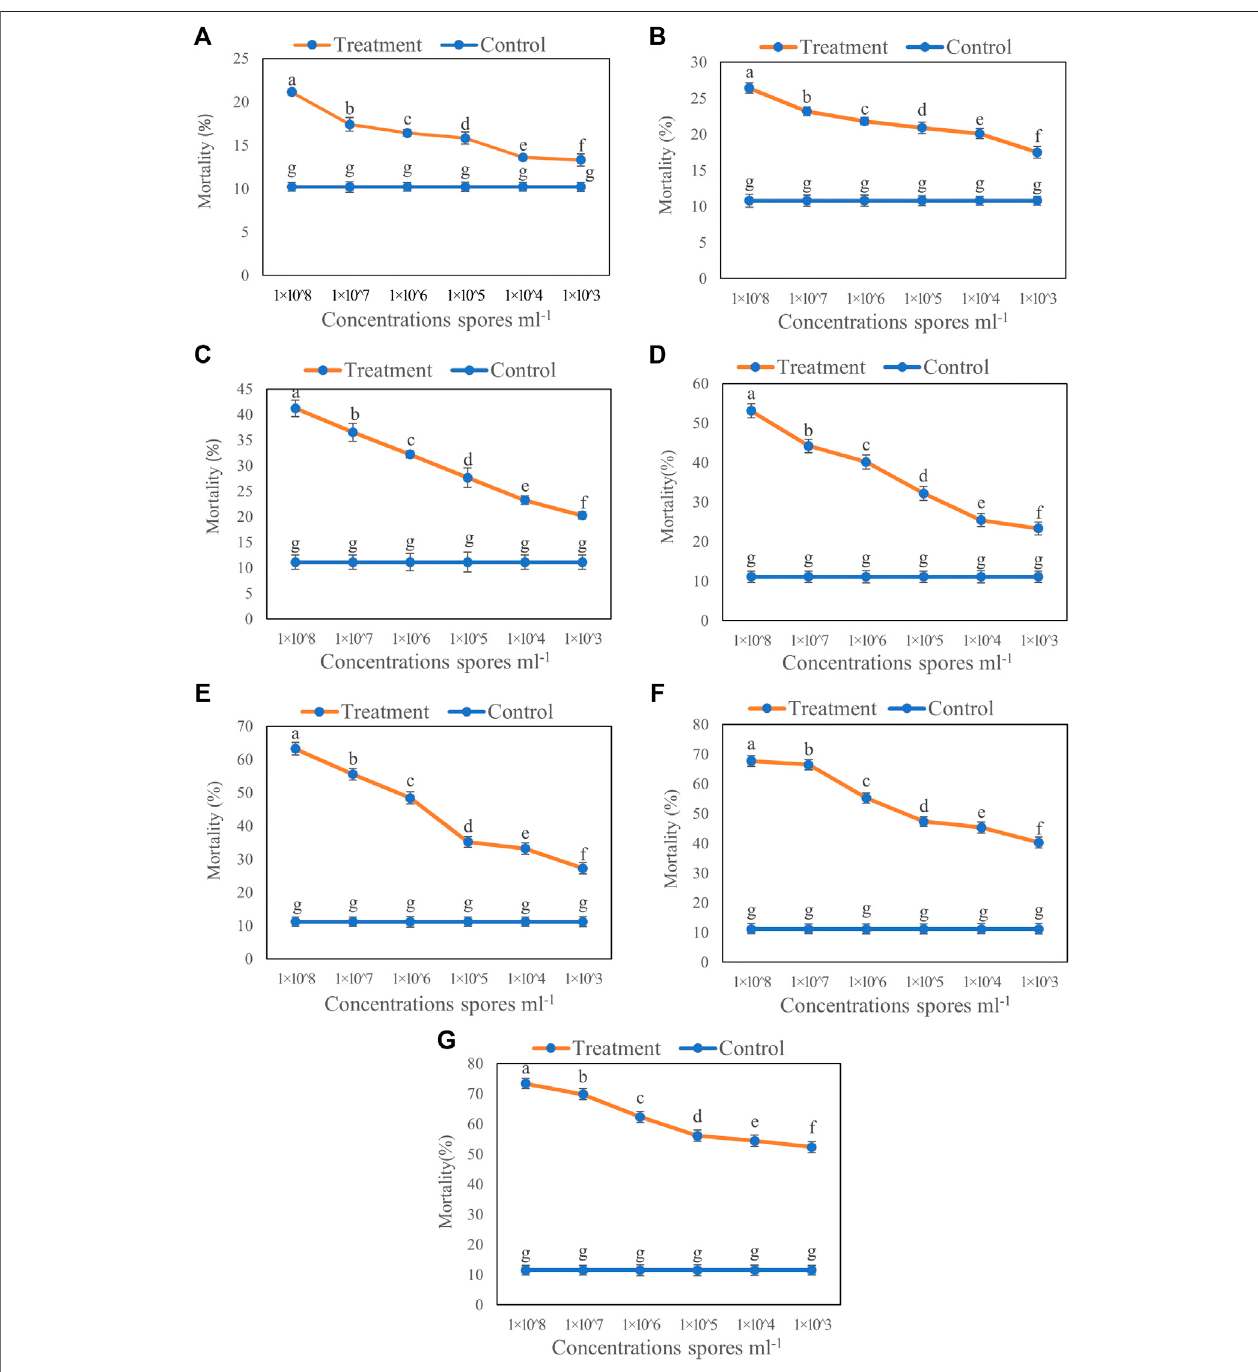
FIGURE1| Mortalityof B.brassicae aftertreatedwithdifferentconcentrationsof T.longibrachiatum T6sporesuspensionat (A) Day1, (B) Day2, (C) Day3, (D) Day 4, (E) Day5, (F) Day6and (G) Day7bythedippingmethod.Differentsmalllettersrepresentthesigni fi cantdifferenceatthe p < 0.05levelbyDuncan ’ snewmultiplerange test. The line bars represent means ± standard